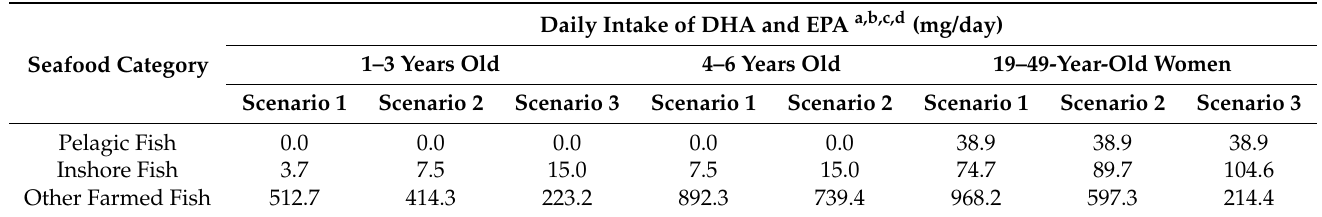
Table A2. Daily intake of DHA and EPA (mg/day) based on the maximum consumption advisory in this study.